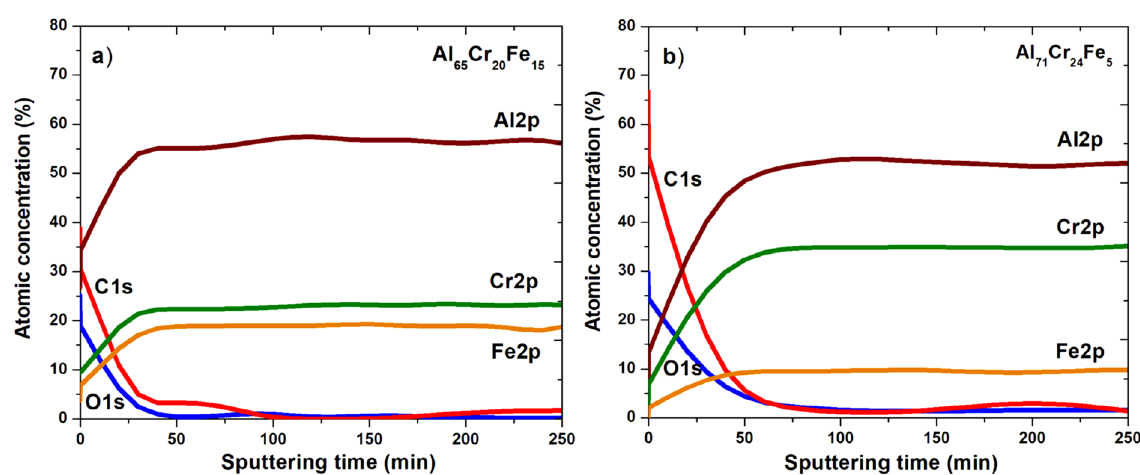
Figure 13. DP-XPS results for Al 65 Cr 20 Fe 15 ( a ) and Al 71 Cr 24 Fe 5 ( b ) alloys in a form of plates after corrosion tests in 3.5% NaCl solution at 25